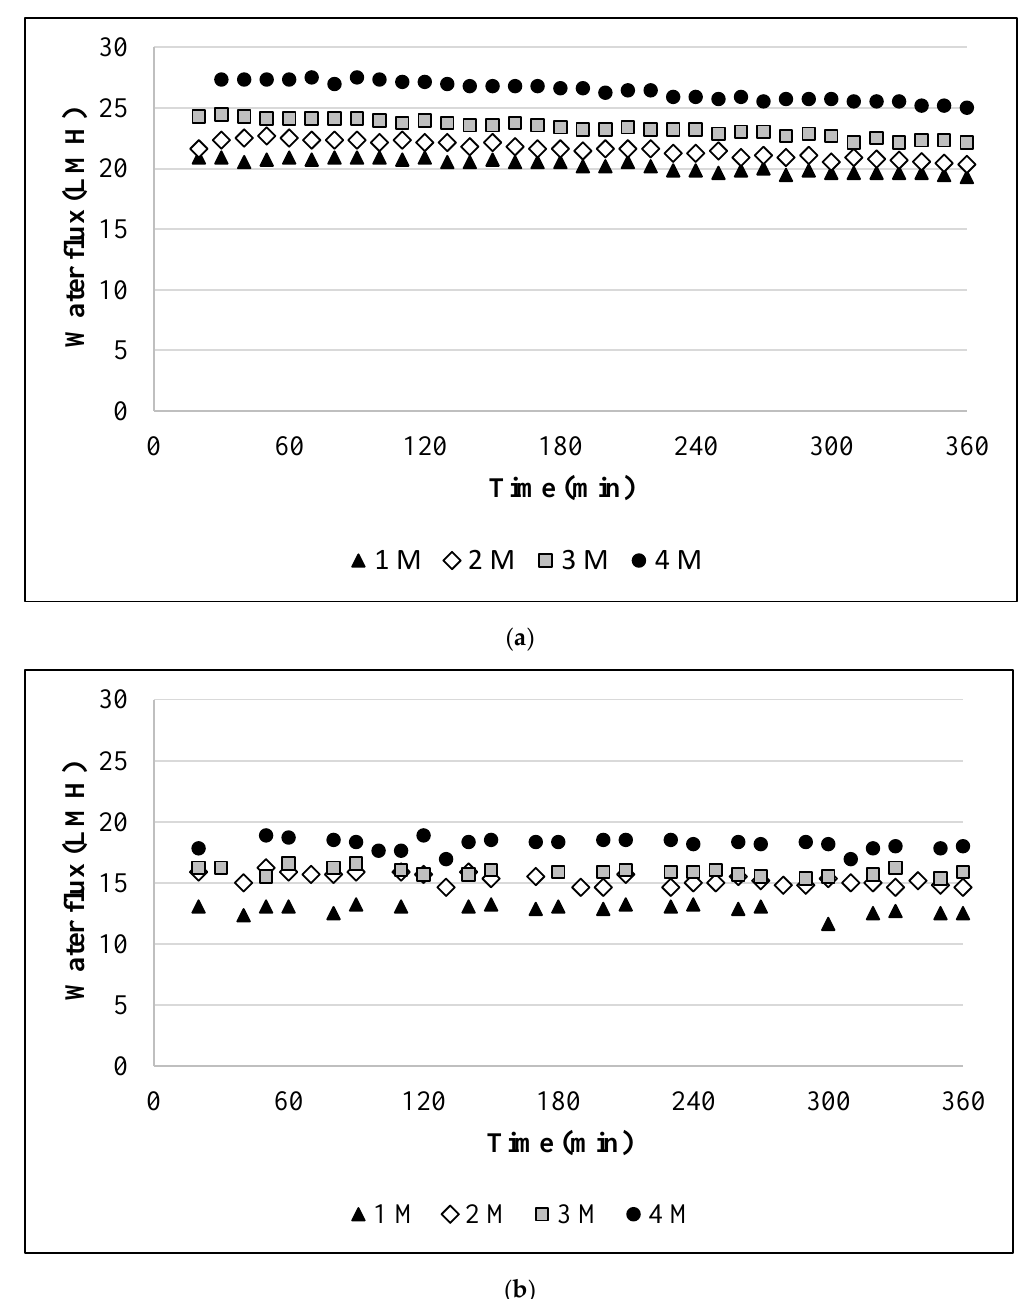
Figure 1. The water flux of the membrane in the absence of scalants: ( a ) active layer-facing draw solution (AL-DS) orientation; and ( b ) AL-feed solution (FS) orientation. Experimental conditions: concentrations of NaCl, CaCl 2 , and Na 2 SO 4 in the feed are 10, 0, and 0 mM, respectively; 12.5 cm / s cross-flow velocity; and the feed and draw solutions were circulated counter-currently.